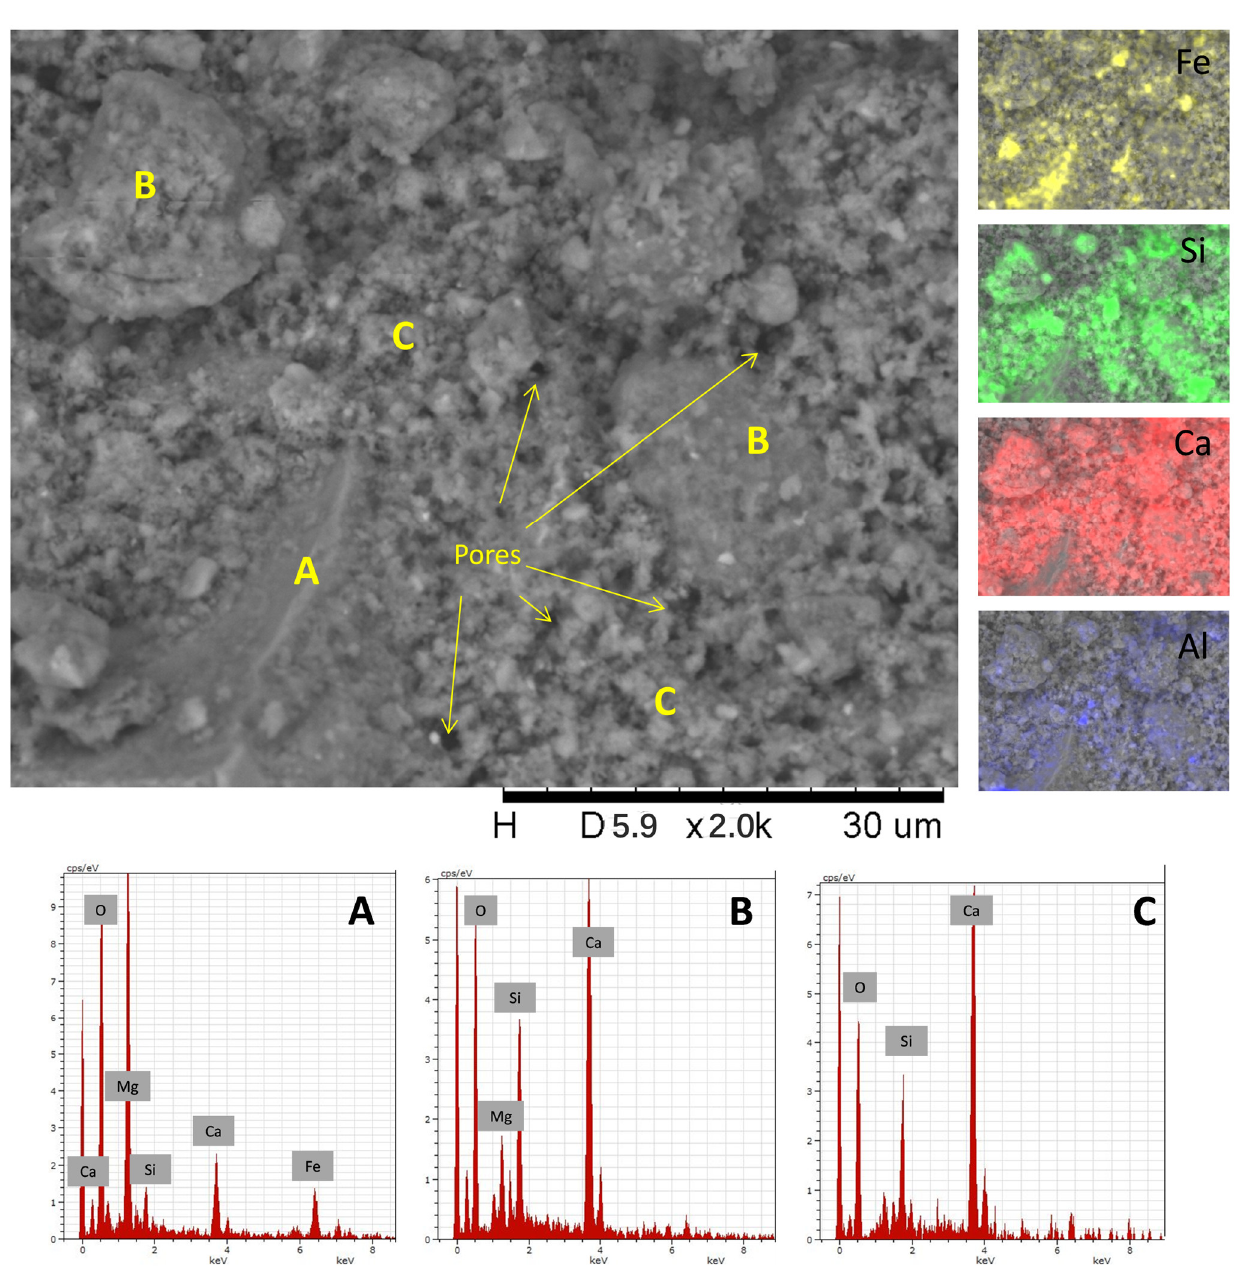
Figure 15. SEM image of 0.75M-4% (magnification of 2000 × ) with elemental mapping and EDX spectra of the scanning points: ( A ) RO phase, ( B ) calcium silicate (unreacted BOF slag particle) and ( C ) C-S-H (reaction product).